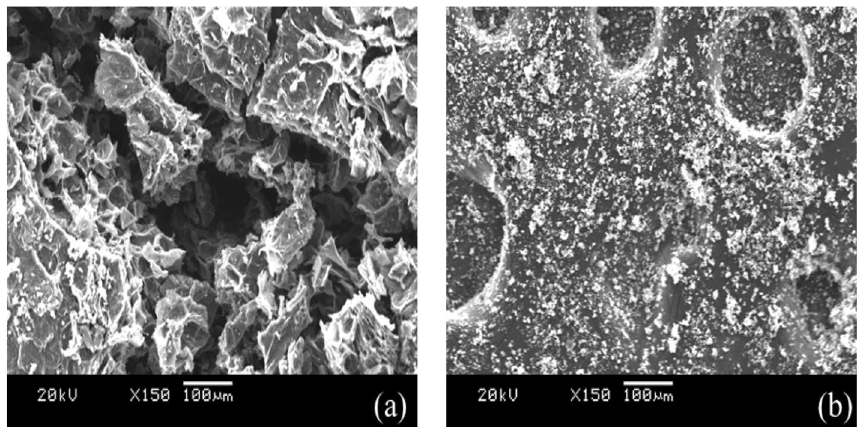
Figure 3. SEM images of (a) WAS-BC, (b) after ball milling of